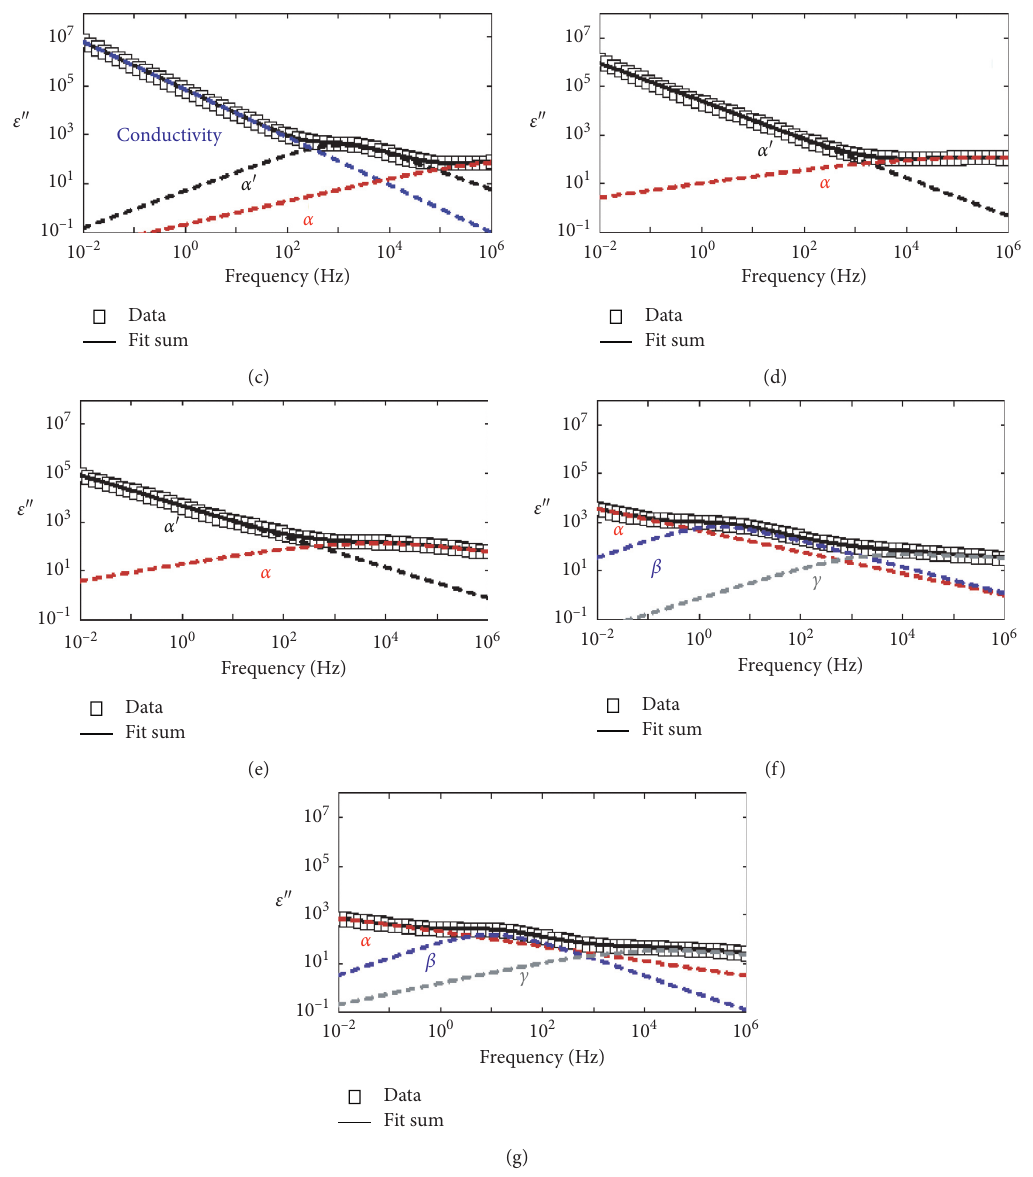
Figure 4: Decomposed relaxation process of NBR for seven representative temperatures (a) 404K (b) 359K (c) 326K (d) 293K (e) 272 K (f) 251 K, and (g) 233K. Five relaxation processes, α ′ (black dashed line), α (red dashed line), β (blue dashed line), c (gray dashed line), and conduction (navy dashed line), contribute to the imaginary permittivity